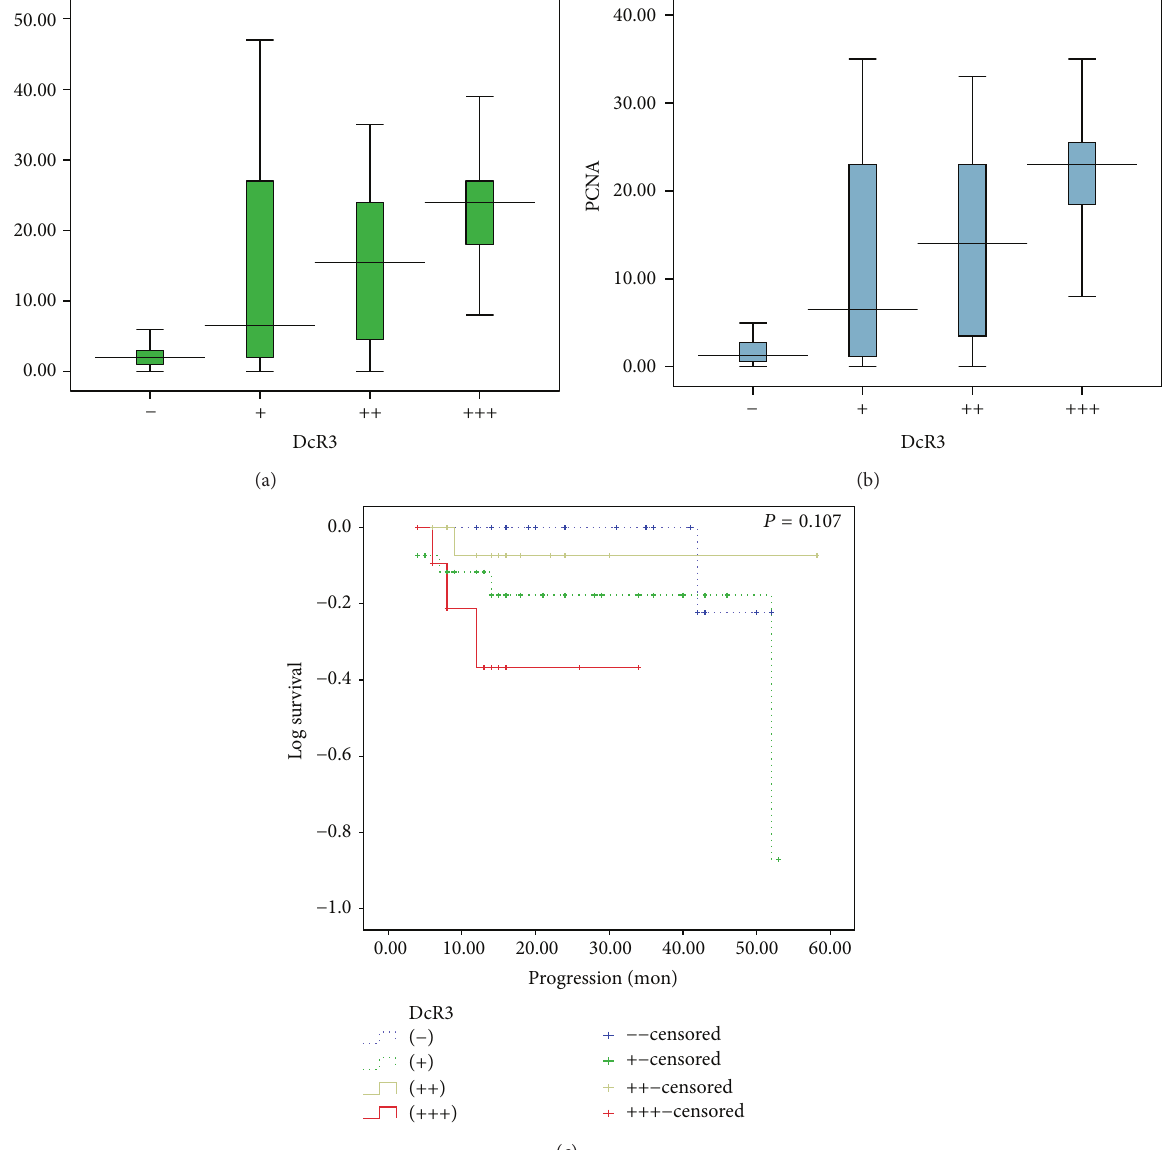
Figure 3: Correlation of DcR3 expressions with proliferation and survival. The relationship between DcR3 expression and labeling indexes (LIs) of Ki-67 (a), PCNA (b), and survival